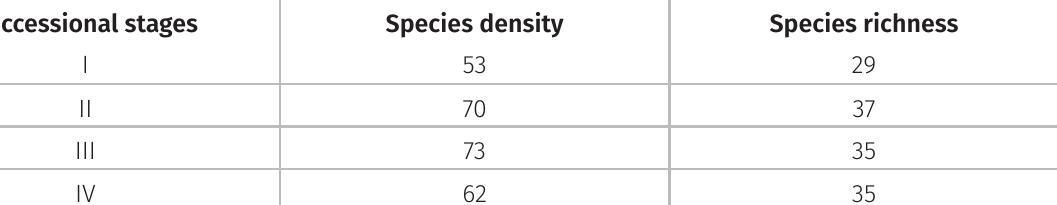
Figure 1. Multidimensional Non-Metric Scaling (NMDS) of bryophyte species composition across the four successional stages in the Caxiuanã